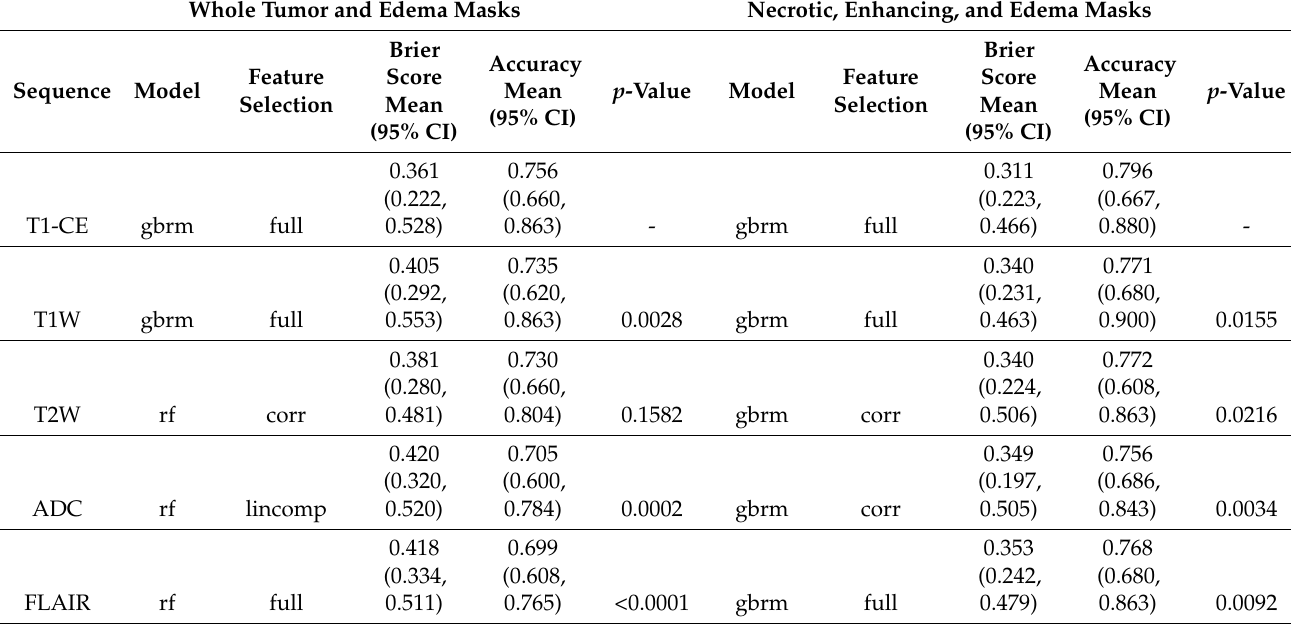
Table 2. Predictive performance of individual MRI